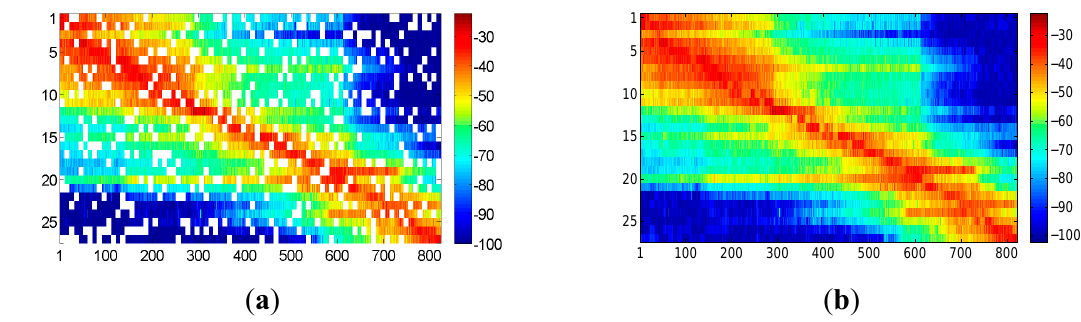
Figure 16. Online RSS reading vector recovery (for 5 access points randomly powered off). ( a ) Sensed online RSS reading vectors; ( b ) Recovered online RSS reading vectors.